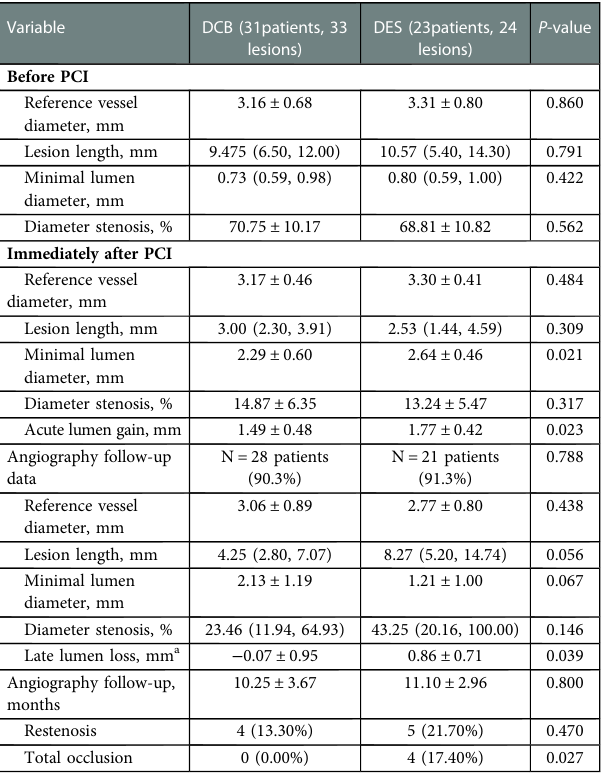
TABLE 3 Quantitative coronary angiography measurements.